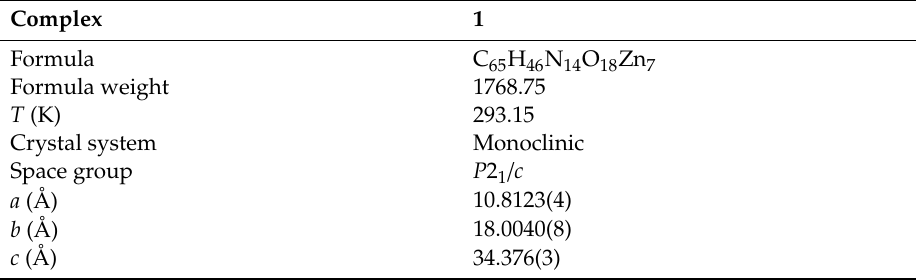
Table 1. Crystallographic data of the complex 1